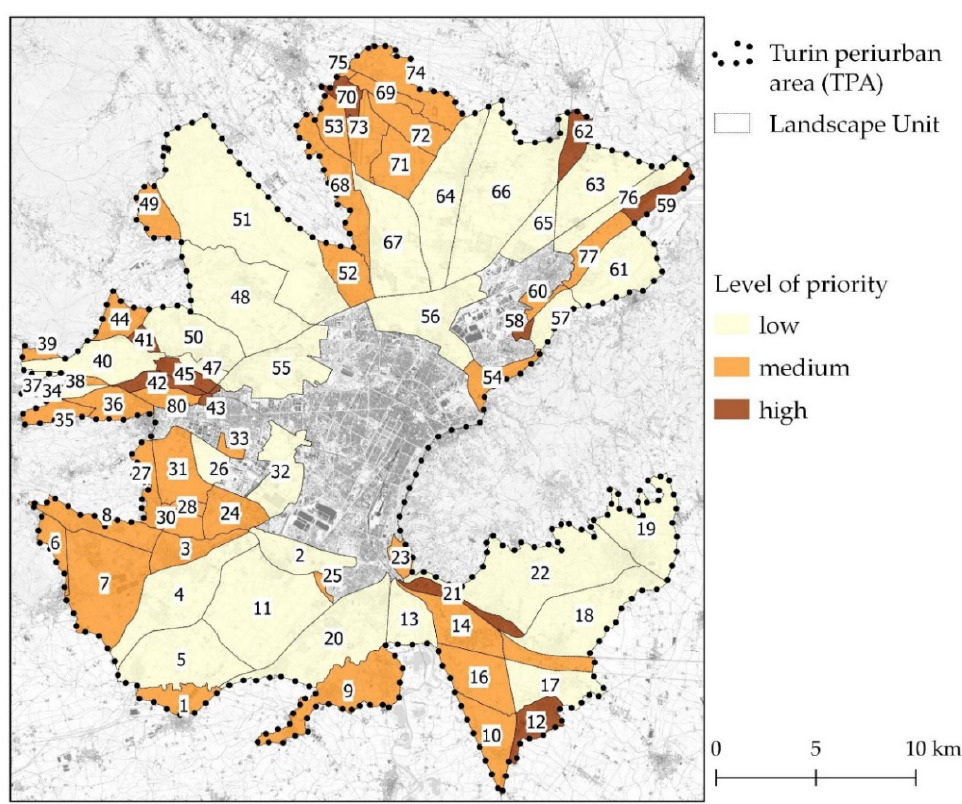
Figure 6. Functional classification according to the following functions: ( a ) food provision; ( b ) historical and cultural; ( c ) ecological; ( d ) scenic; ( e ) recreational.